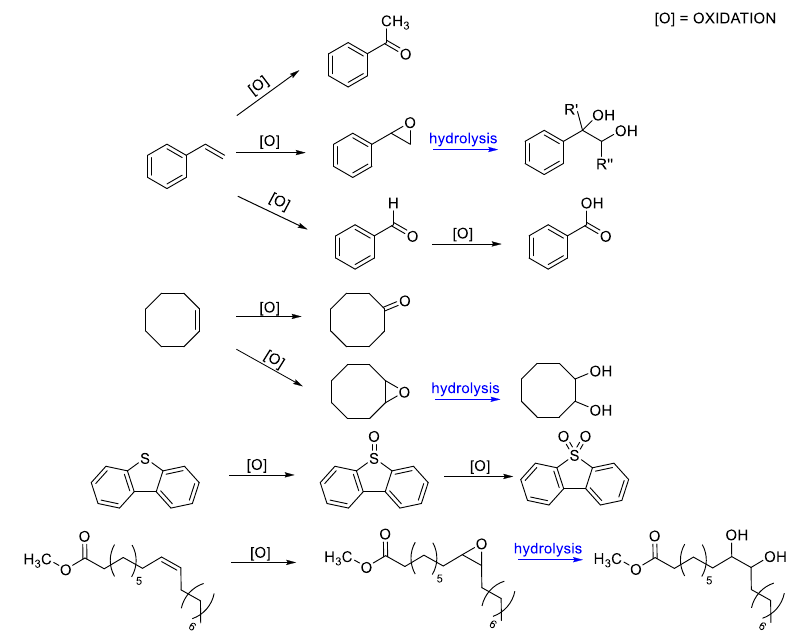
Figure 6. Schematic representation of the main substrates and their oxidation products analyzed by our research group.